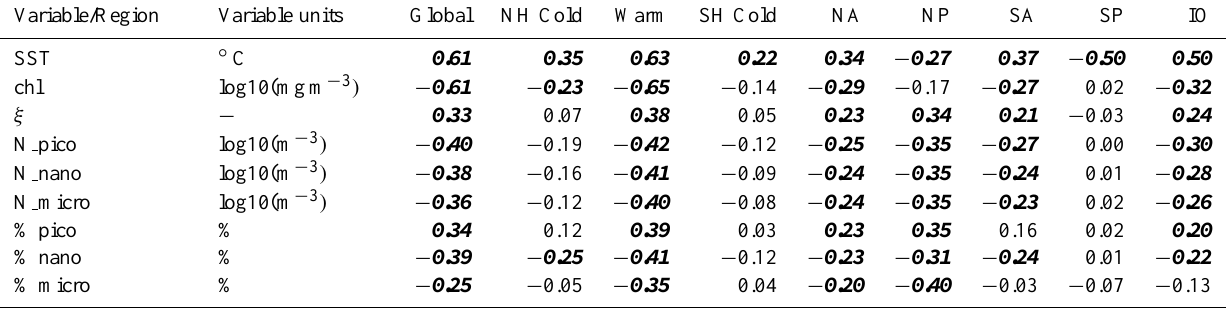
Table 2. Table of linear correlation coefficients of the monthly anomalies of SST, chl, and PSD variables with the multivariate ENSO index (MEI). Period of analysis: Sep 1997–Dec 2007 (124 months). Significant correlations at the 95% confidence level are indicated in bold and italics. The MEI used is in units of 1/1000’s of standard deviations (Wolter and Timlin, 1998, see also web link in Sect. 2.5). A positive MEI corresponds to the warm phase of El-Ni˜no, i.e. a positive correlation coefficient means that the variable was increasing in value when there were El-Ni˜no events and/or that it was decreasing in value when there were La-Ni˜na events. All months that are involved in trend computations are included here, i.e. winter months are excluded from the polar regions, just like for the trends analysis (Sects. 2.4 and